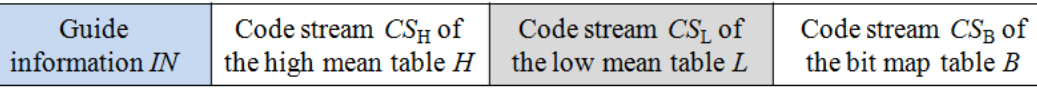
Figure 3. The structure of the code stream CS.